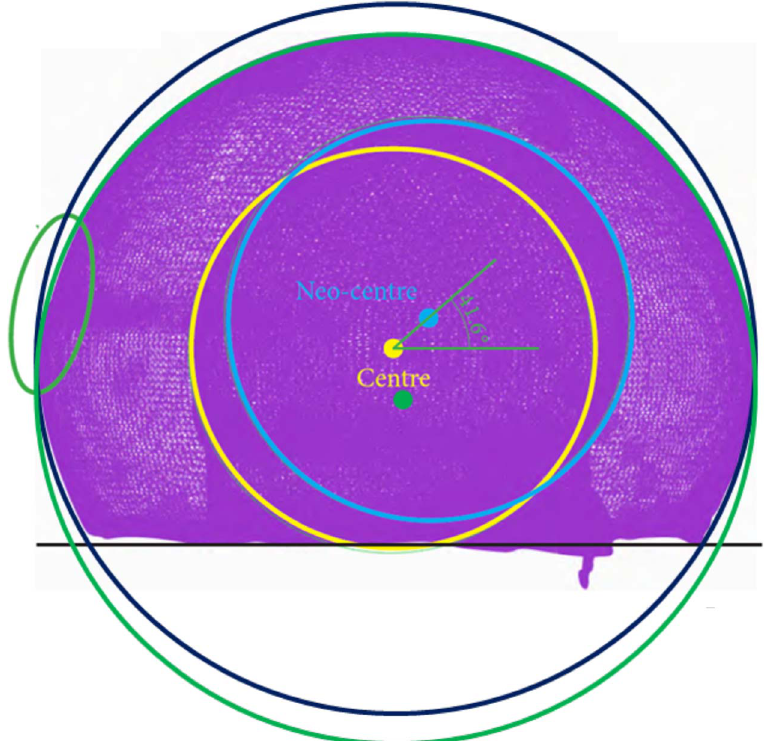
Figure 5. Internal (2.5 mm) and external wear (2.1 mm) of the polyethylene liner. Liner centre (in green), native head centre of the construct at the implantation (in yellow), and new head centre of the explant after wear (in blue).